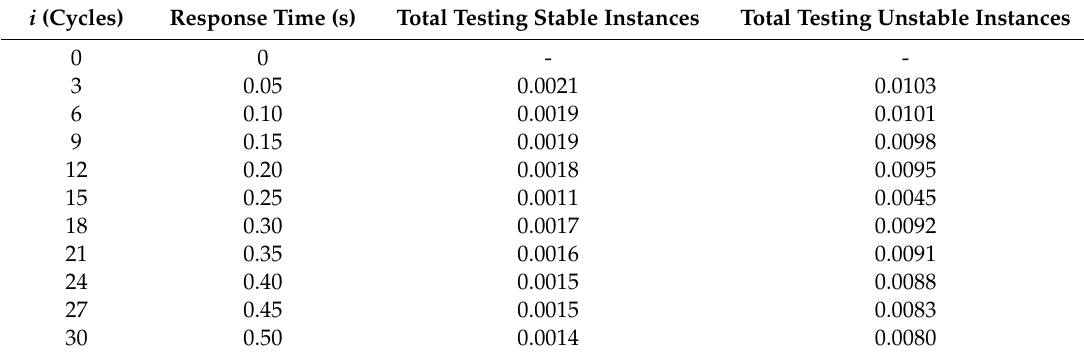
Table 4. Mean squared errors (MSEs) at di ff erent decision times of total testing stable instances and unstable